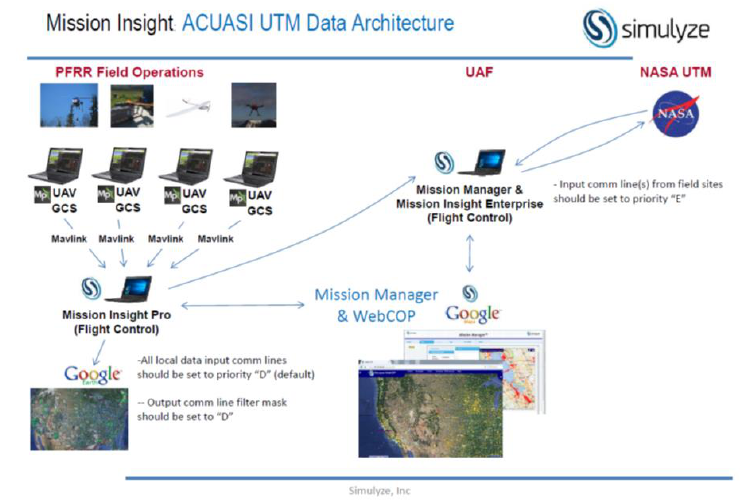
Figure 9. UTM architecture for UAF TCL1 [22] (p. 9).